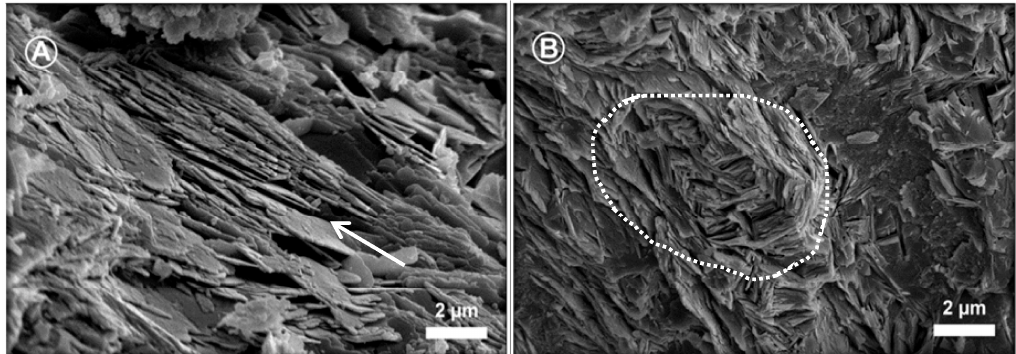
Figure 5. Two distinctive morphologies of bismoclite from San Francisco de los Andes seen under SEM (Sample 05–BiOCl–02): ( A ) Platy bismoclite crystals. Note the well-developed cleavage parallel to the (001) plane (white arrow). ( B ) A rosette-like bismoclite aggregate is shown in the white dotted line.